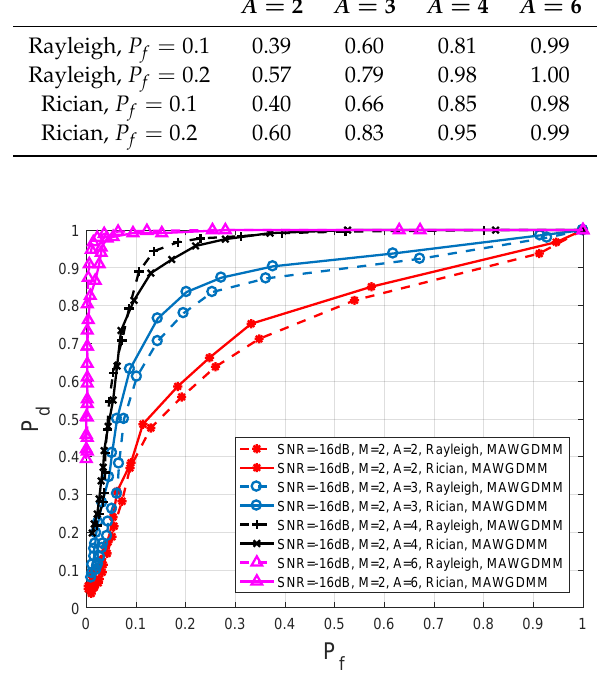
Figure 10. Comparison of ROC in different number of